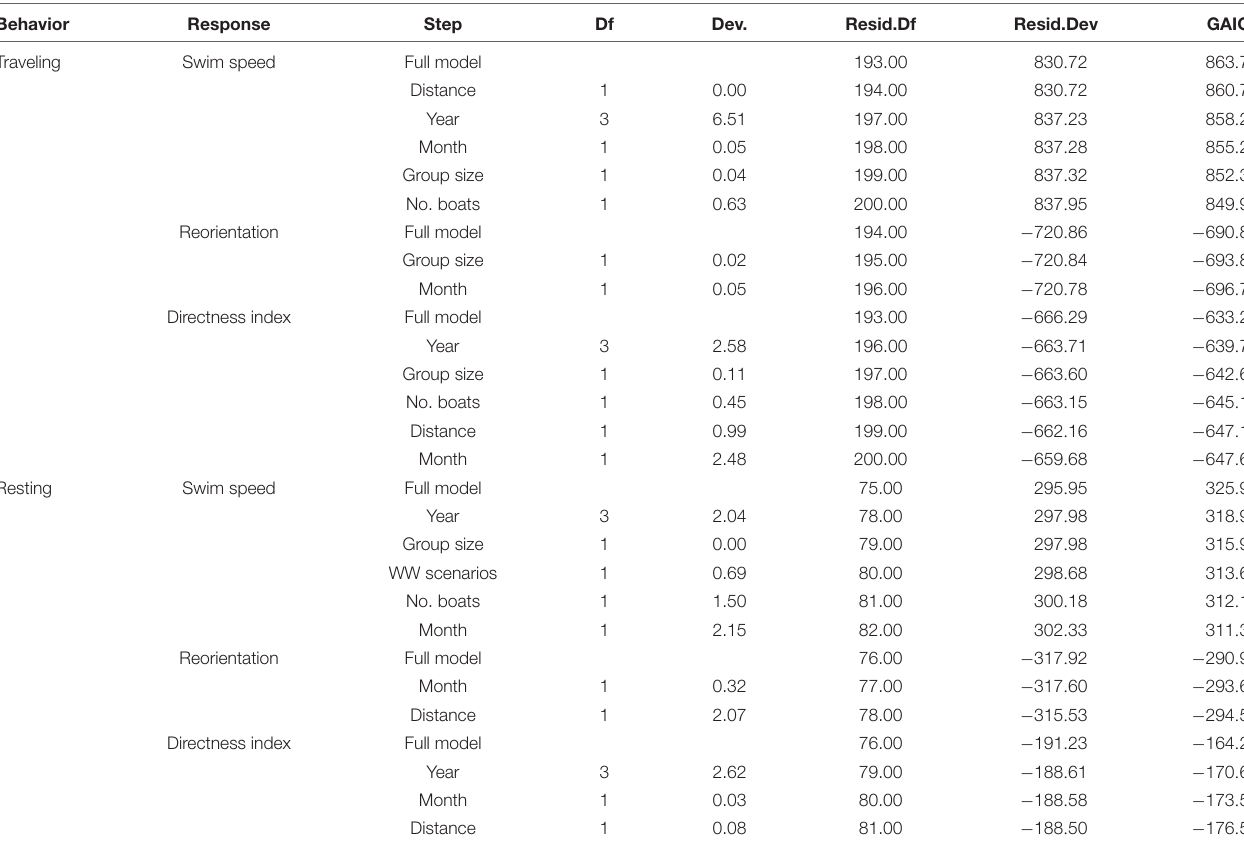
TABLE 1 | Results from the backward stepwise model selection of swim speed, reorientation, and directness index for traveling and resting behaviors of fin whales. Behavior Response Step Df Dev. Resid.Df Resid.Dev GAIC Traveling Swim speed